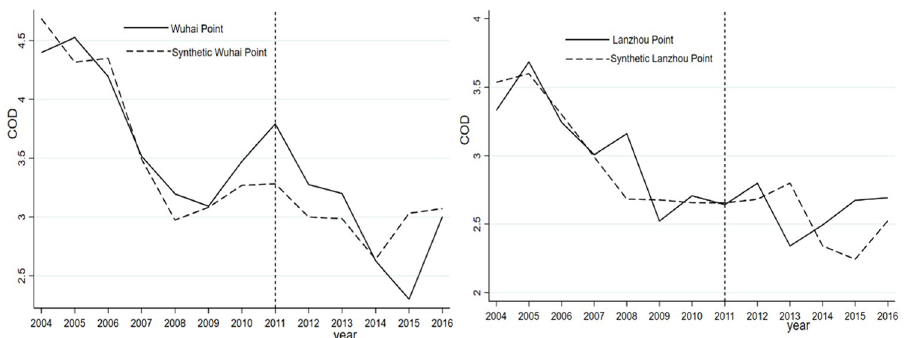
Fig 7. The synthetic effect of COD on the largest and smallest weights in the control